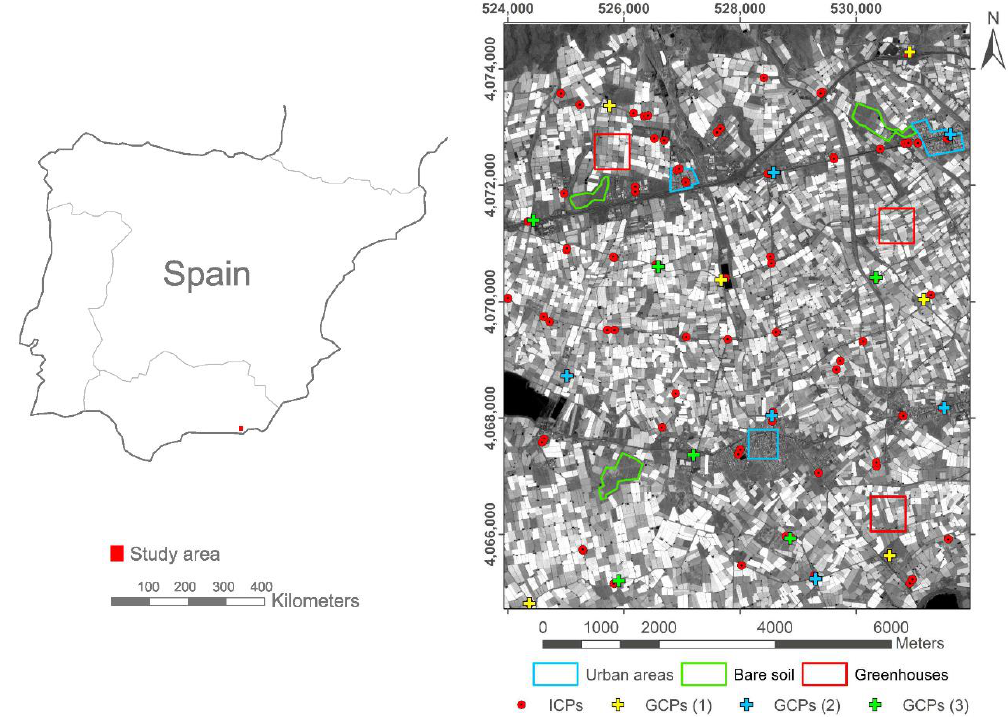
Figure 1. Location of the study area in Almeria (Spain). The nine selected subareas representing urban areas, bare soil and plastic covered greenhouses are depicted in blue, green and red polygons, respectively. Independent check points (ICPs) are represented with red points, while ground control points (GCPs) appear as crosses (six in green, six in blue and six in yellow). Coordinate system: WGS84 UTM zone 30N.